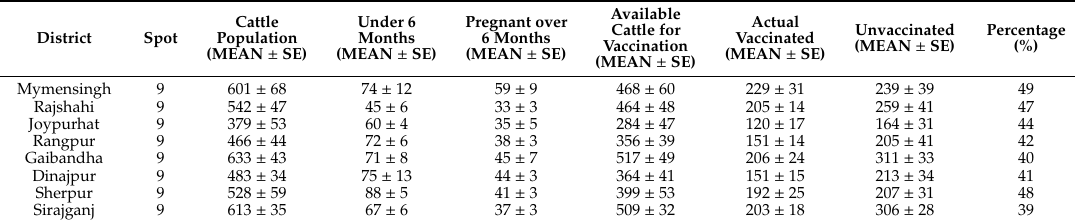
Table 1. The Livestock population and average vaccination intake in di ff erent study locations.